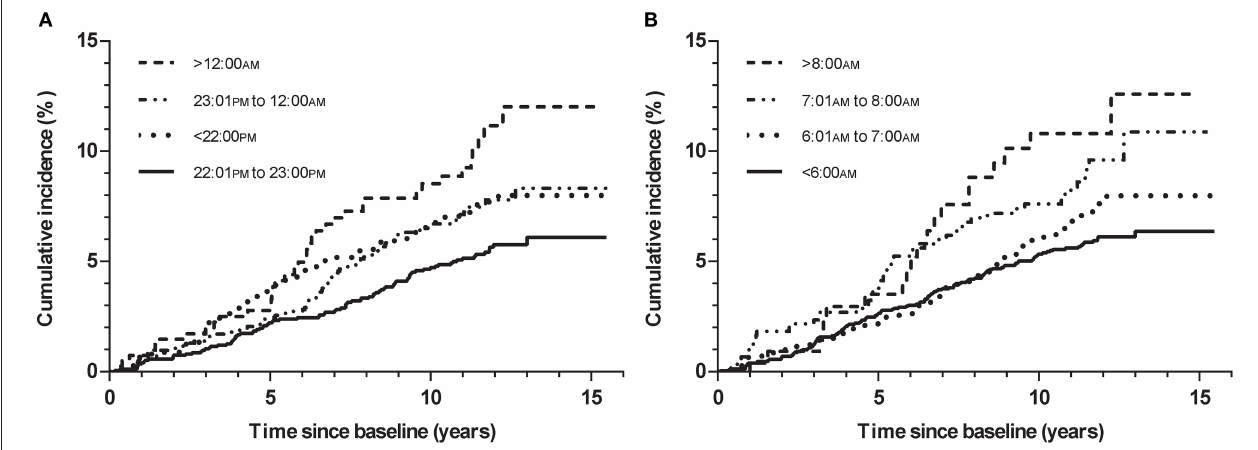
FIGURE 2 | Kaplan-Meier plots of cumulative risk for MI stratified by different categories of bedtime and wake-up time on weekday. (A) : Weekday bedtime and MI; (B) : Weekday wake-up time and MI.